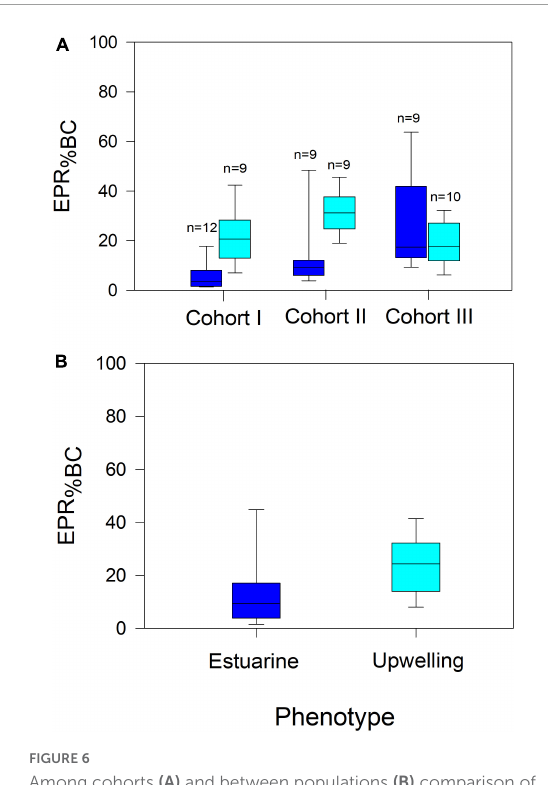
FIGURE6 Among cohorts (A) and between populations (B) comparison of specific EPR (EPR %BC ). Significant EPR %BC variations were found among cohorts of both populations, in which upwelling females produced comparatively more eggs per body carbon than estuarine females. n denotes the number of observations for each cohort.